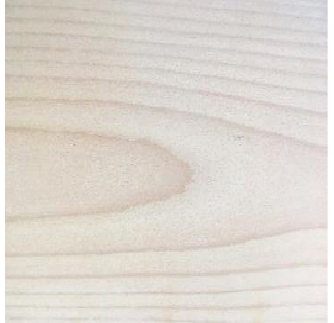
Figure 1. Beech wood